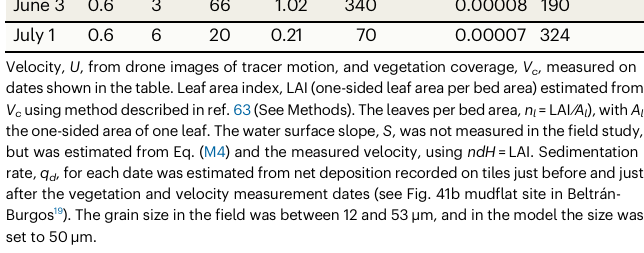
sediment can be carried into the marsh. The curves of M nd ,1m (dashed lines) were smoothedwith a moving average. b Pattern2. In cases with resuspension ( τ n > τ c,n , e.g., base cases n =40 and 60m − 2 ) M nd ,1m / M in,n increases with distance from marsh edge until SSC pro fi le reaches equilibrium at L eq , indicated by black arrows.